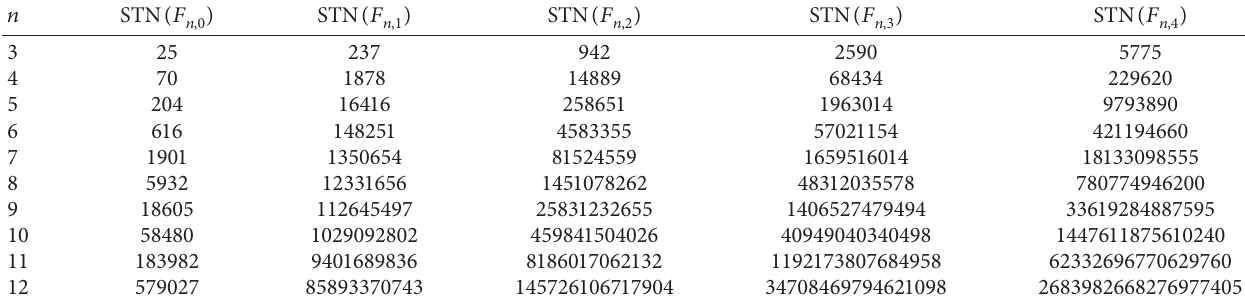
) of F ( n � 3 , ... , 12 ; k � 0 , . .. , 4 ) n,k n,k